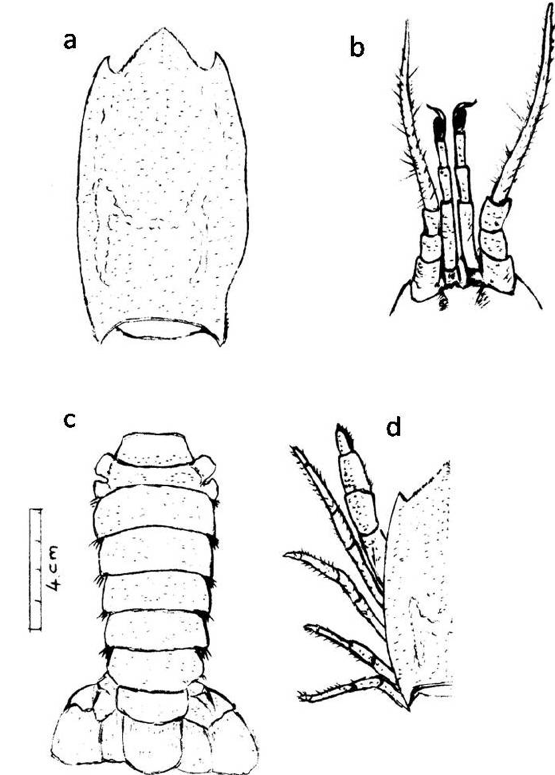
Figure 2. Palinurellus wieneckii (De Man, 1881), female (MTRLDST 0564). a - dorsal view of carapace, b - ventral view of antenna, antennules with peduncles, c - dorsal view of abdominal segments d - dorsal view of lateral carapace and